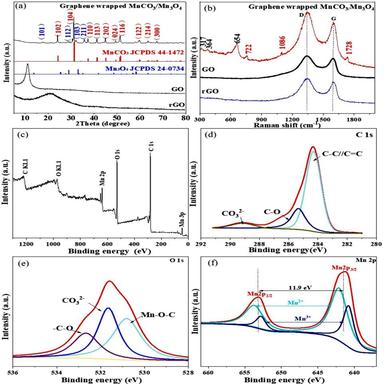
(a) XRD pattern, (b) Raman spectrum, (c-f) XPS spectra: (c) Survey spectrum and (d-f) high-resolution spectra of C 1 s, O 1 s and Mn 2p of graphene-wrapped MnCO3/Mn3O4 nanocomposite.